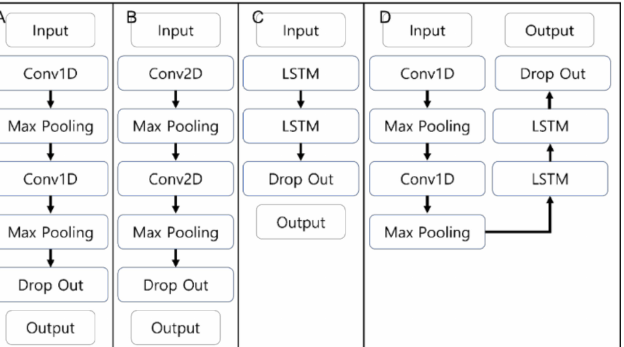
Figure 2. Structures of deep learning models: ( A ) 1D-CNN, ( B ) 2D-CNN, ( C ) LSTM, and ( D )